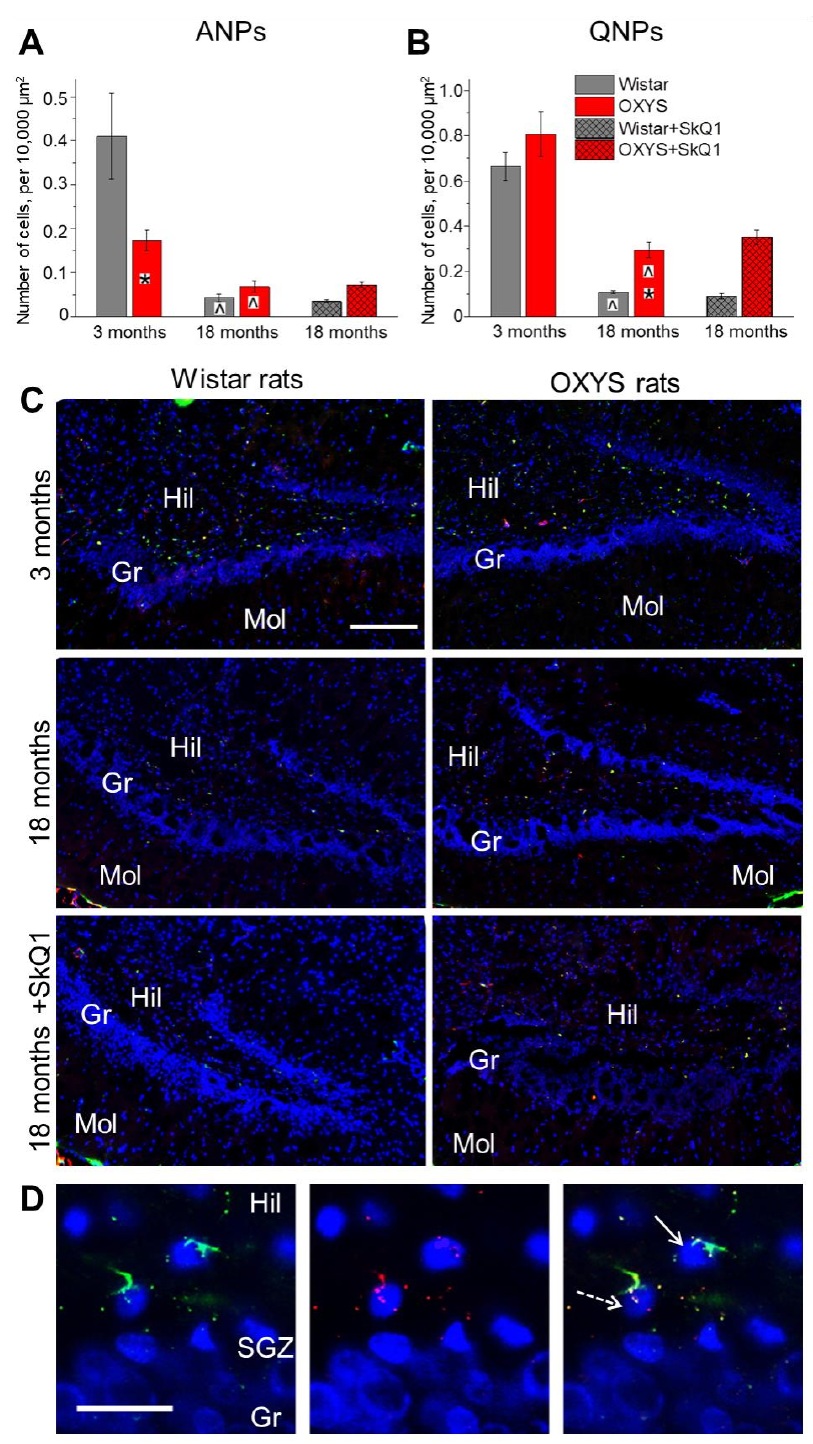
Figure 1. The density of neuronal progenitors in the dentate gyrus (DG) of OXYS and Wistar rats at 3 and 18 months of age, as well as after dietary supplementation with SkQ1 (a mitochondria-targeted antioxidant). ( A ) The density of amplifying neural progenitors (ANPs) was lower in OXYS rats at 3 months of age relative to Wistar rats. ( B ) OXYS rats had higher quiescent neural progenitor (QNP) density at 18 months of age than Wistar rats. ( C ) Immunohistochemical staining of the DG with antibodies against nestin (green) and vimentin (red). The scale bar is 200 µ m. ( D ) A